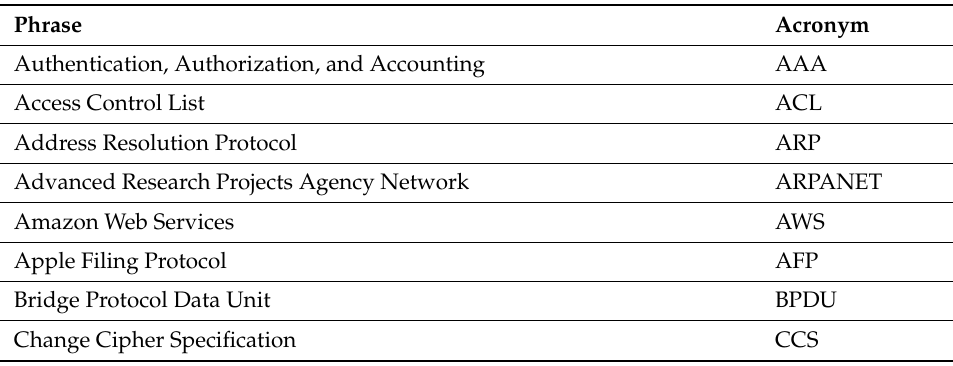
Table 1. Most used phrases and their